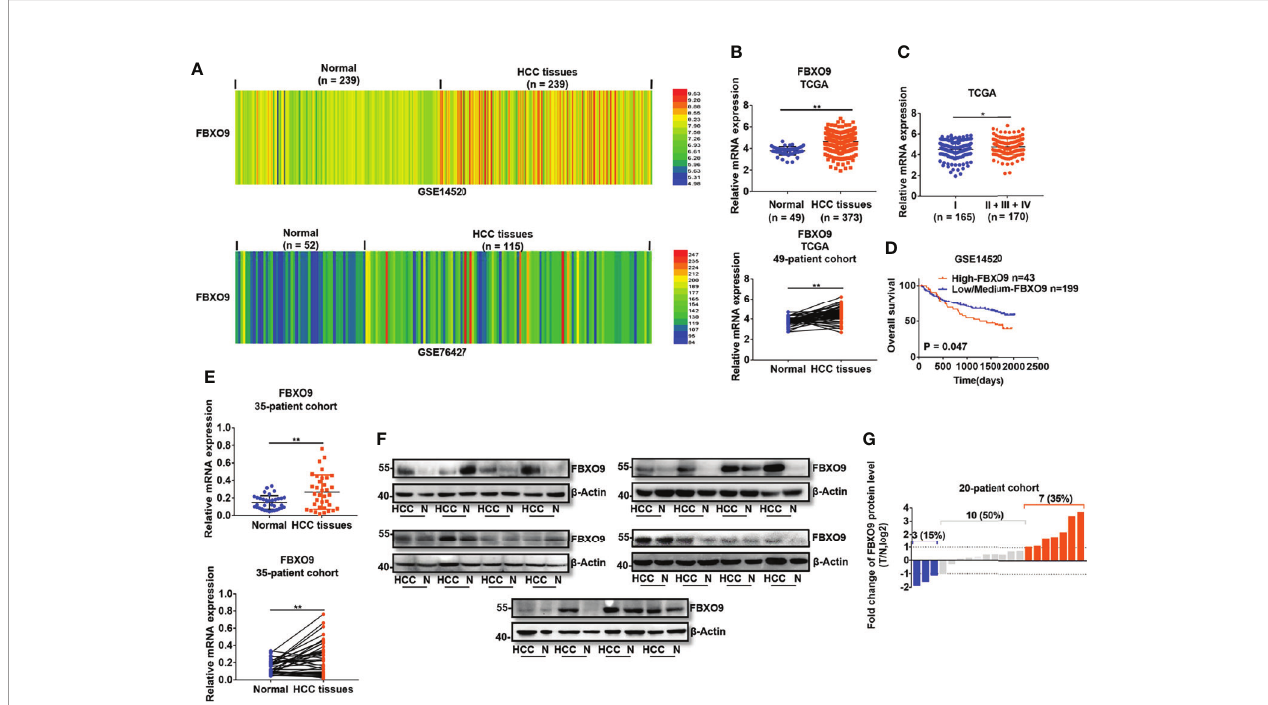
FIGURE 1 | FBXO9 is upregulated in HCC. (A, B) The expression of FBXO9 in HCC tissues and noncancerous liver tissues in GSE14520, GSE76427, and TCGA database. (C) Expression of FBXO9 in HCC tissues of early pathological stage (Stage I) and advanced pathological stage (Stage II-IV) in TCGA database. (D) Kaplan- Meier analysis of overall survival in patients with low/medium expression or high expression of FBXO9 in GSE14520 dataset. (E) qPCR analysis (above, two-sided unpaired t -test; below, two-sided paired t -test) of FBXO9 transcription in 35 paired HCC tissues and paired nontumorous tissues in our lab. (F) Western blot of FBXO9 expression in 20 paired HCC tissues (HCC) and normal (N) samples in our lab. (G) Waterfall plot showing the protein level of FBXO9 in HCC tissues compared with adjacent noncancerous tissues from 20 patients, as determined by western blotting. Red histogram, FBXO9 overexpressed more than two times in HCC tissues compared with normal tissues; blue histogram, FBXO9 decreased more than two times; grey histograms, FBXO9 overexpressed or decreased by no more than twice. The data are presented as mean ± SD, *, P < 0.05, **, P < 0.01 by two-tailed Student's t